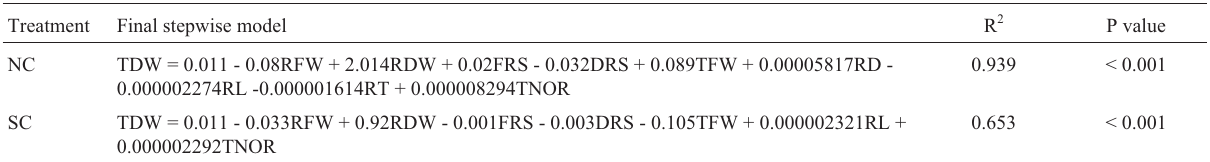
Table3 -Multiplelinearstepwiseregressiontoexplaintotaldryweight(TDW)fromroottraitsbuiltwith Aegilopstauschii genotypesmeans.Fortraitab- breviations see Table 1.